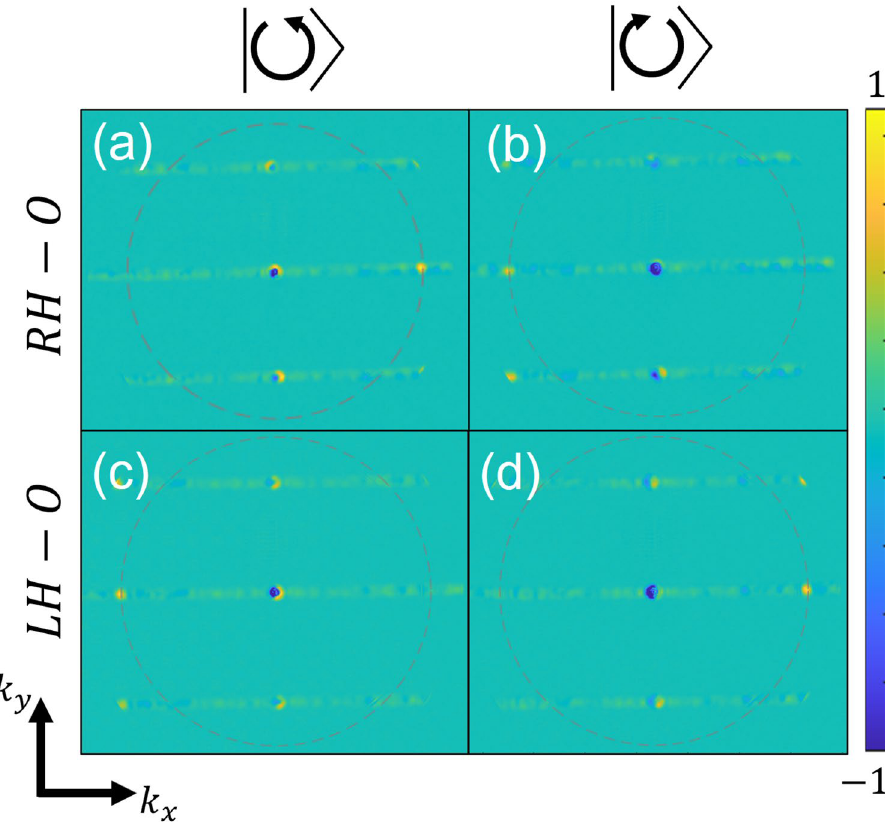
Figure 4. Averaged k -space distributions measured with different rotating gratings contrasted with the averaged results from the corresponding non-rotating structures. ( a , c ) Correspond to the RCP illumination and ( b , d ) for the LCP. Pictures ( a , b ) were taken from the right-handed structures and ( c , d ) were measured with the left-handed